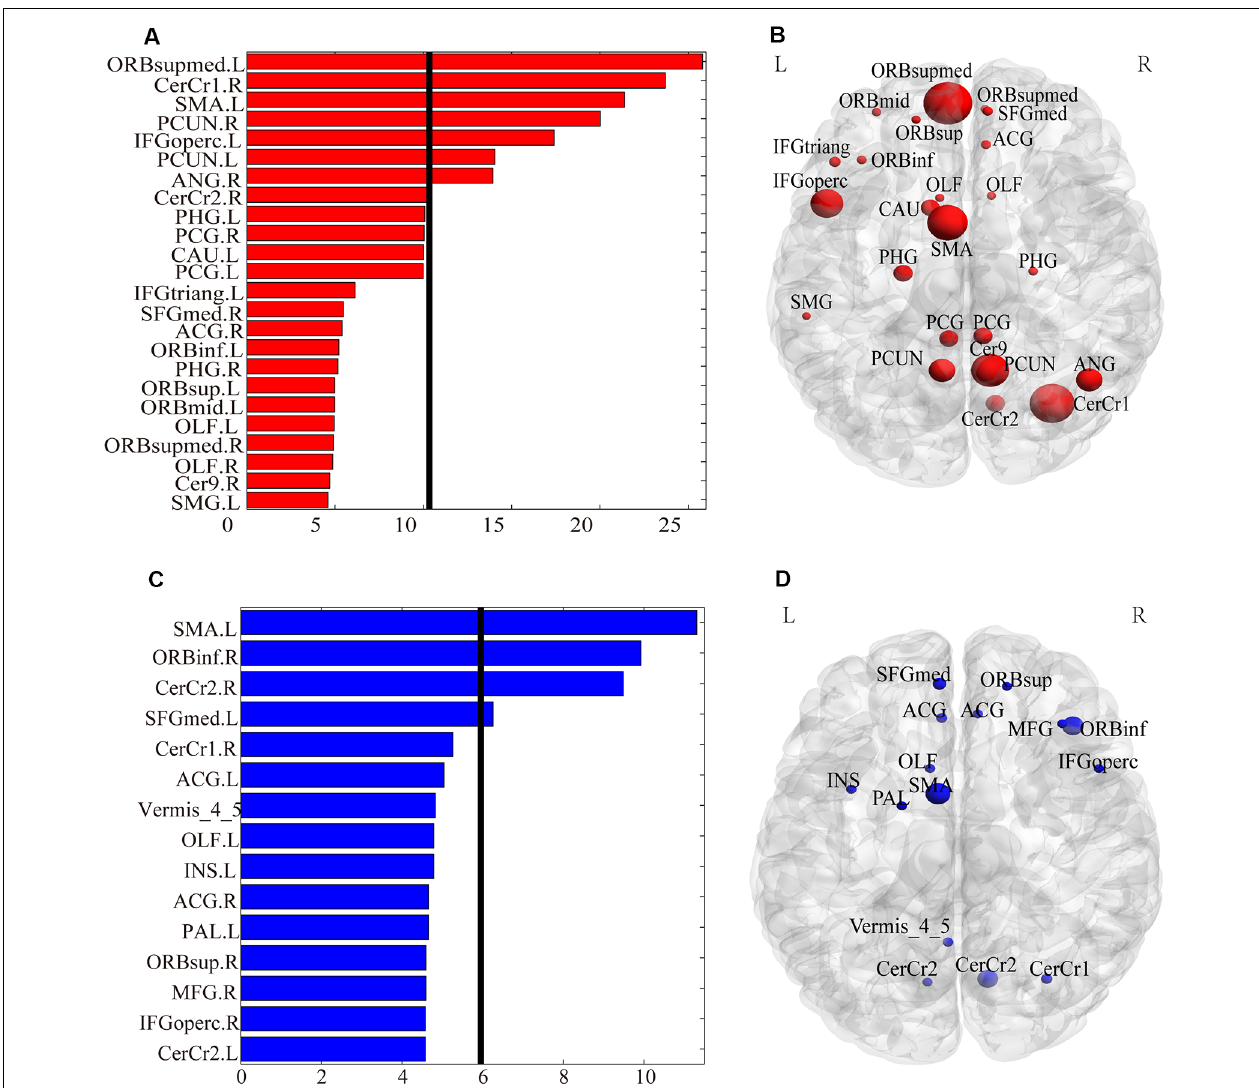
FIGURE 3 | The weighted degree of the brain regions involved in the FCs with significant gender differences. Panels (A,B) show the bar plot and the rendering plot of the weighted degree of the regions with significantly higher values in females than in males (in red). Panels (C,D) show the bar plot and the rendering plot of the weighted degree of the regions with significantly higher values in males than in females (in blue). In Panels (A,C) , the black lines indicate the mean value. In panels (B,D) , the size of the spheres indicates the value of the weighted